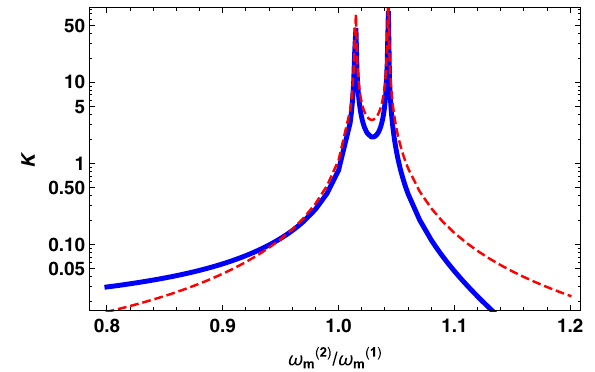
that diverge zx ω ð 2 Þ m . The solid 1 Þ m ,